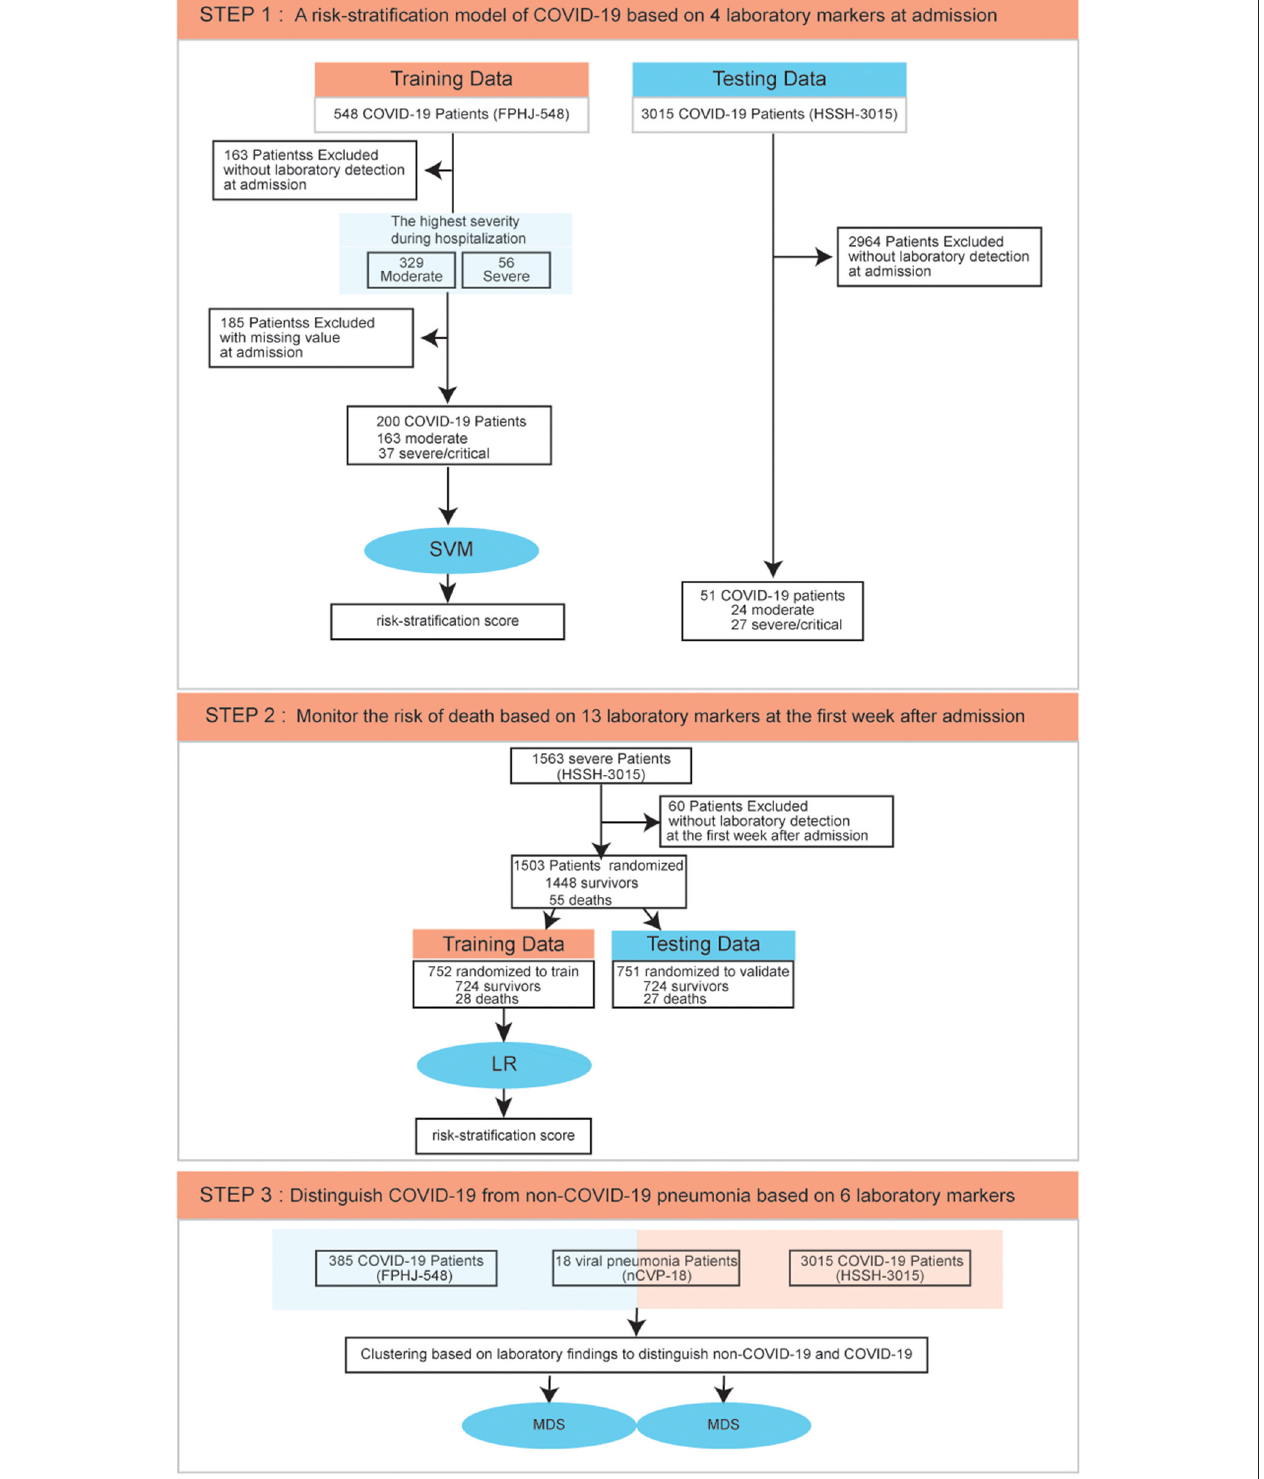
FIGURE 1 | Data process flowchart. SVM, Support Vector Machine; LR, Logistic Regression; MDS, Multidimensional Scaling.